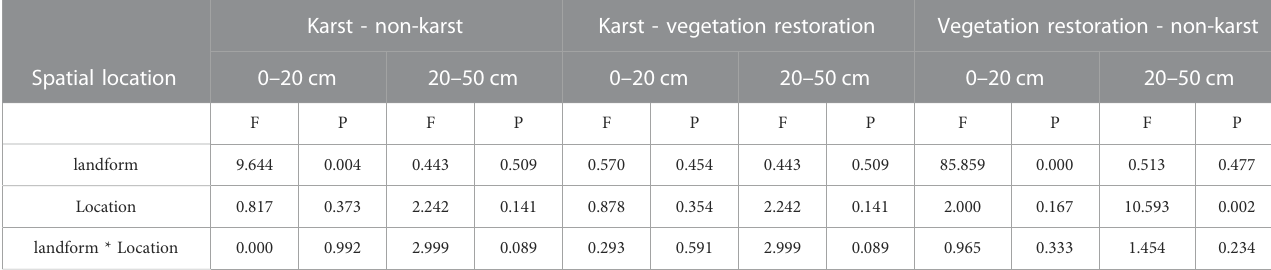
TABLE 4 Generalized linear mixed model (GLMM) analysis of SOC. Karst - non-karst Karst - vegetation restoration Vegetation restoration - non-karst